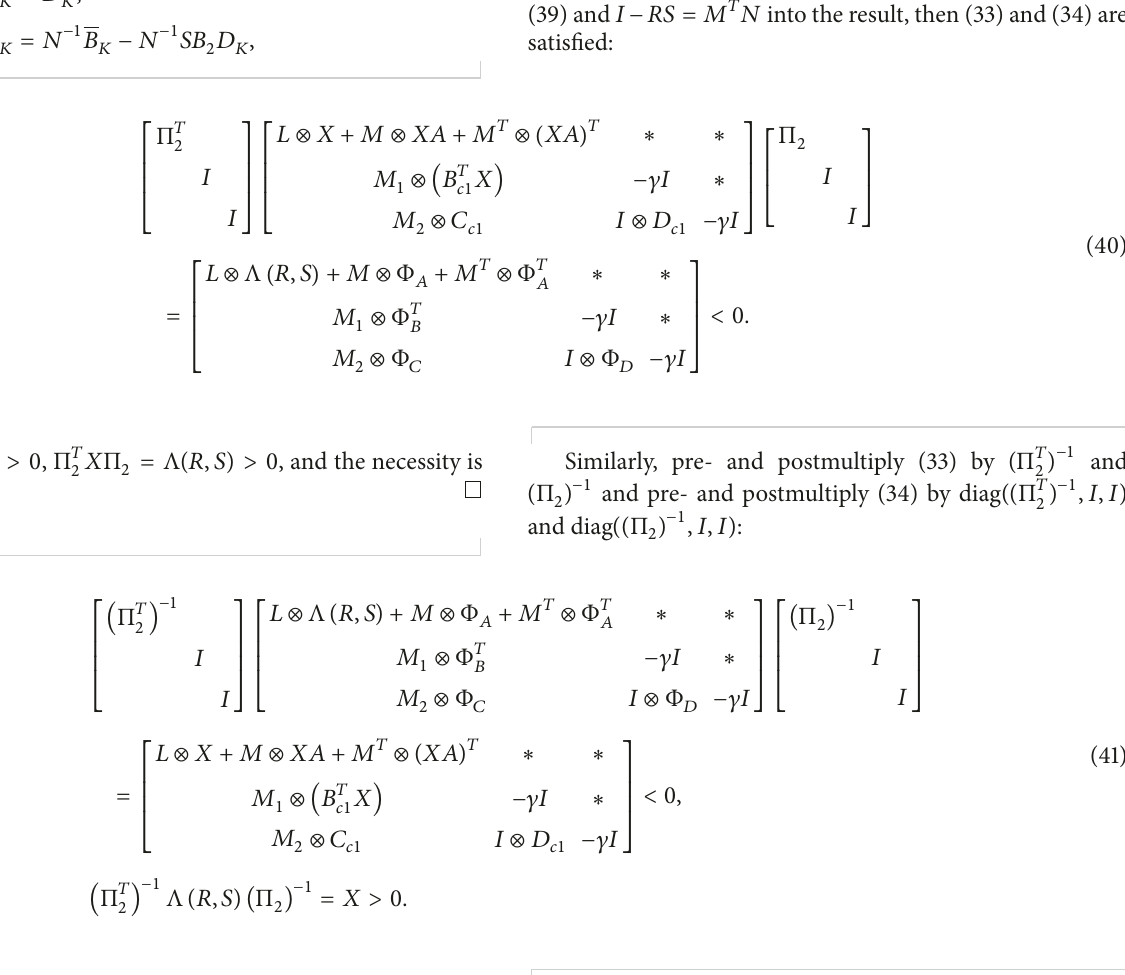
uncertainty Δ 𝑖 (𝑠) under different wind speed, shown in Figure 5. The uncertain switched system of aeroelastic model